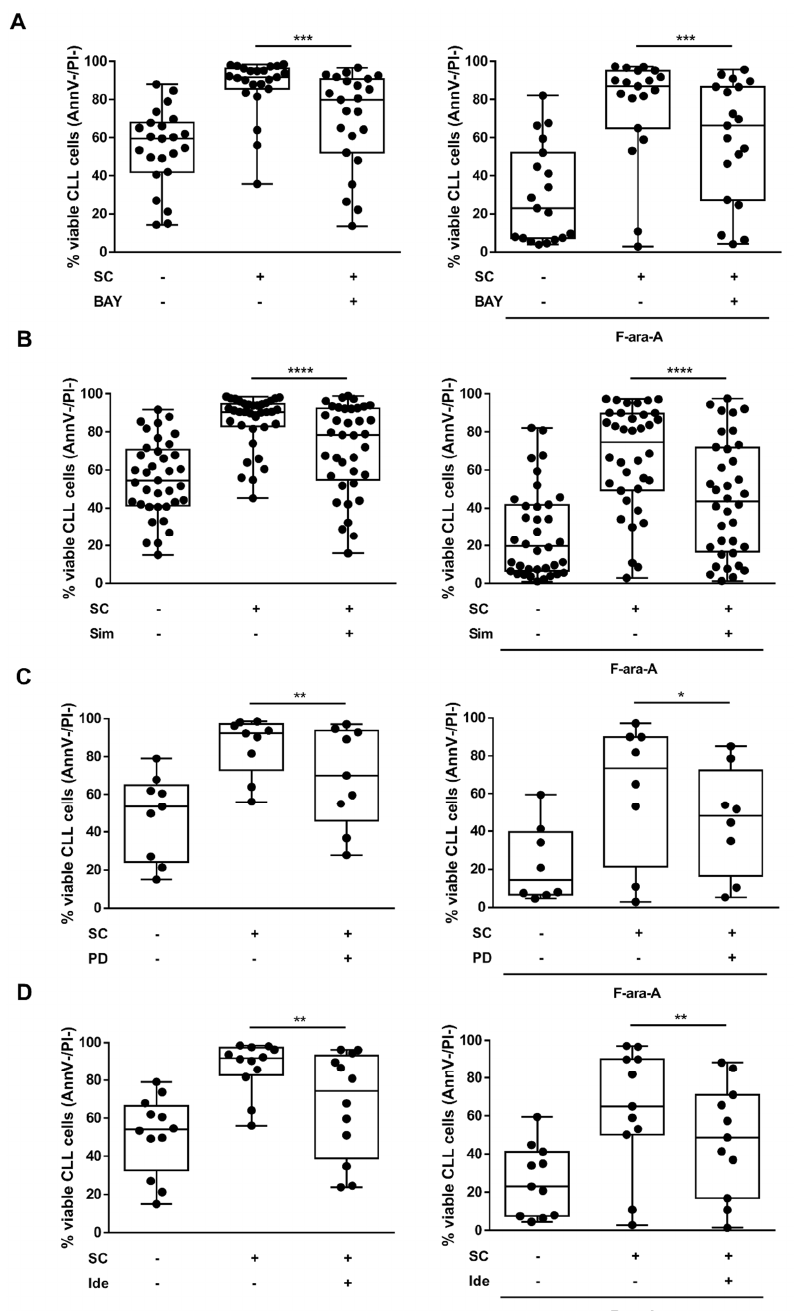
Figure 3. Inhibitors of HIF-1 α regulatory pathways counteract SC protection toward spontaneous and fludarabine-induced leukemic cell death. CLL cells were cultured alone or in the presence of M2-10B4 SC. In all experiments, the co-culture with SC resulted in a significantly higher viability as compared to CLL cells cultured alone. Cell cultures were exposed to BAY87-2243 (BAY), simvastatin (Sim), PD98059 (PD) or idelalisib (Ide), alone or in association with fludarabine (F-ara-A). Cell viability was evaluated after 48 h treatment. The addition of BAY87-2243 ( A ), simvastatin ( B ), PD98059 ( C ) and idelalisib ( D ) to CLL/SC co-cultures significantly reduced the viability of CLL cells compared to untreated co-cultures, both in the absence and in the presence of fludarabine (left and right panels, respectively). Box and whiskers plots show median values of alive CLL cells percentages, considered as Ann-V-negative and PI-negative (AnnV-/PI-), 25–75% percentiles, and minimum and maximum values for each group; each point represents a single sample value ( n = 23 and n = 19 in ( A ); n = 37 and n = 36 in ( B ); n = 9 and n = 8 in ( C ); n = 12 and n = 11 in ( D )). **** p < 0.0001, *** p < 0.001, ** p < 0.01 and * p <